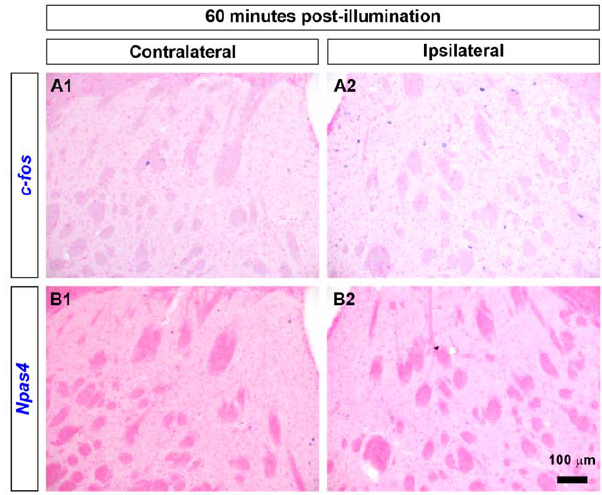
Figure 3. Expression of c-fos and Npas4 in the striatum after 60 minutes of illumination. (A1–B2) No significant expression of either c-fos (A1, A2) or Npas4 (B1, B2) was observed in the striatum after 60 minutes of ChR2(C128S)-mediated activation of MSNs. Scale bar: 100 m m.